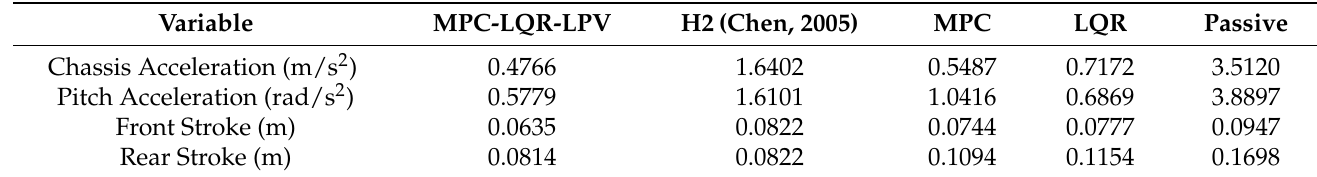
Table 3. Max Values